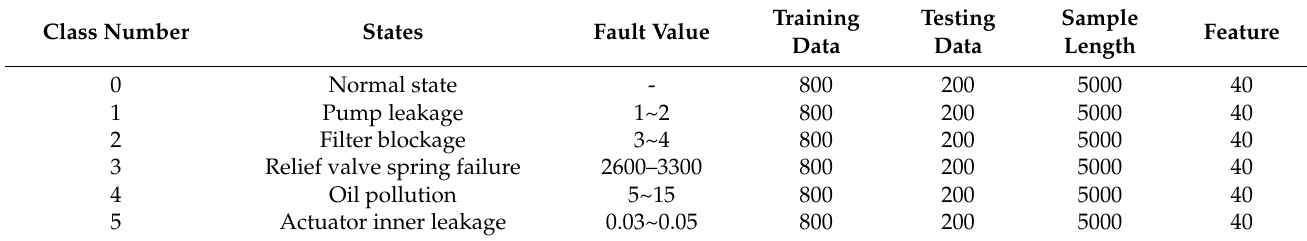
Table 5. Different samples used for the aircraft hydraulic fault